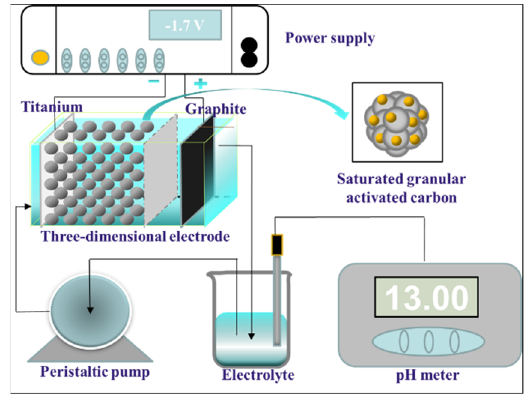
Figure 1. The reaction equipment in electrochemical experiments.